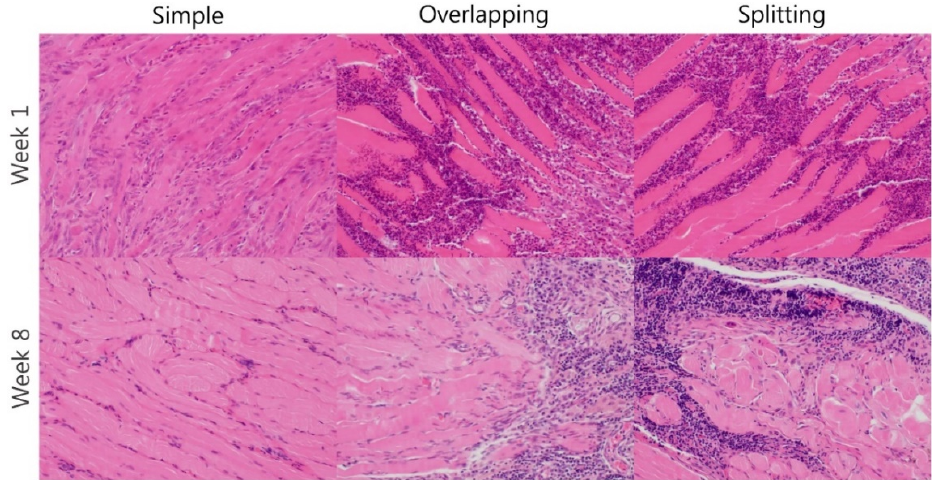
Figure 6. H&E staining. The overlapping and splitting groups exhibited prolongation of infiltration of inflammatory cells into interstitial tissue until week 8. In contrast, inflammatory infiltration was resolved in the simple interrupted suture group at week 8.